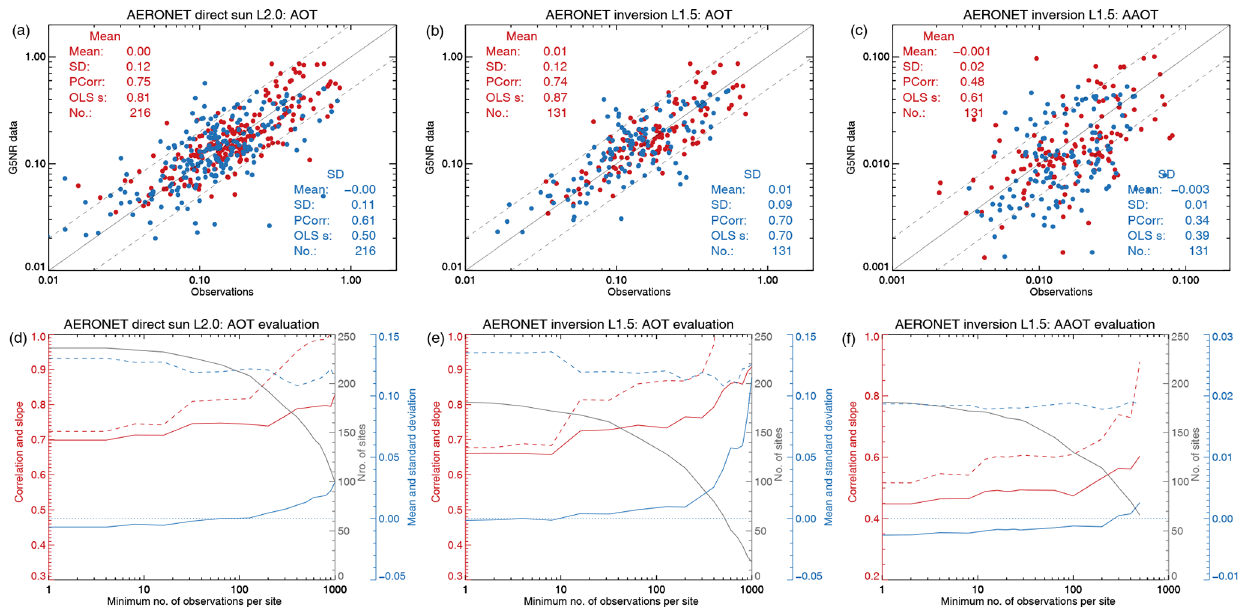
Figure 1. Evaluation of the G5NR simulation of AOT and AAOT with AERONET data. The top row (a, b, c) shows evaluation against three different datasets. Each dot represents the yearly mean or standard deviation for a single AERONET site (with at least 100 observations in 2006); the mean value is shown in red and the standard deviation in blue. The coloured text summarizes the statistics over all data points in the figure. The bottom row (d, e, f) shows the impact of the minimum required number of observations per site on those summary statistics (for means) is shown. Colours relate lines to axes and have different meanings than those in the top row. The solid red line indicates correlation, the dashed red line indicates slope, the solid blue line indicates mean, and the dashed blue line indicates standard deviation. In all figures, hourly G5NR model data were collocated in time and space with AERONET observations before calculating site statistics.